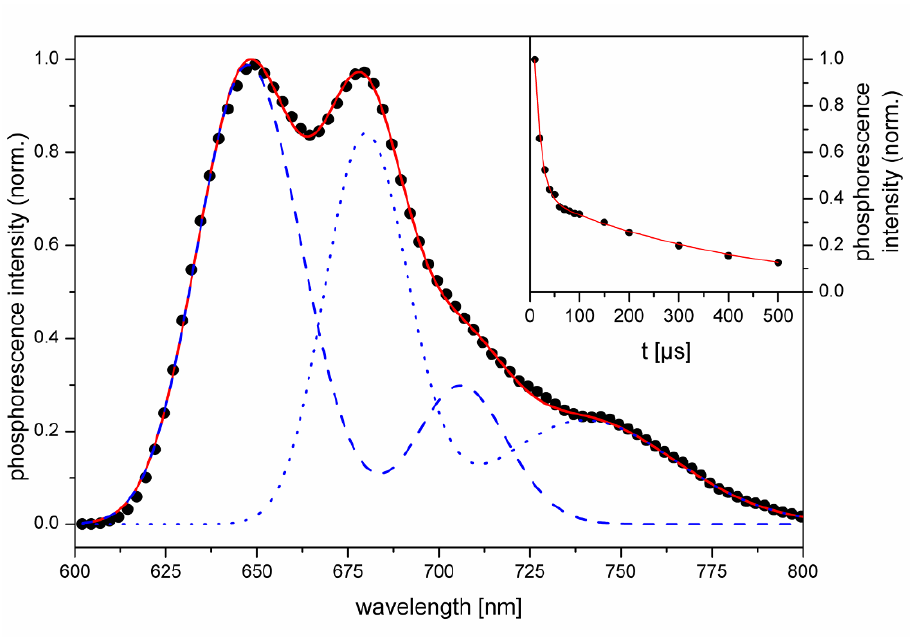
Figure 5. Deconvolution of the emission spectrum of Ru3 at 77 K (full circles) into two separate emissive species with different lifetimes of 12 µs (dashed line) and 214 µs (dotted line). The solid line refers to the resulting fit of the entire emission spectrum. The integrated emission intensity (integration between 630 and 760 nm) as a function of time is depicted in the inset of Fig. 5. The time-dependence of the emission is fit with a biexponential